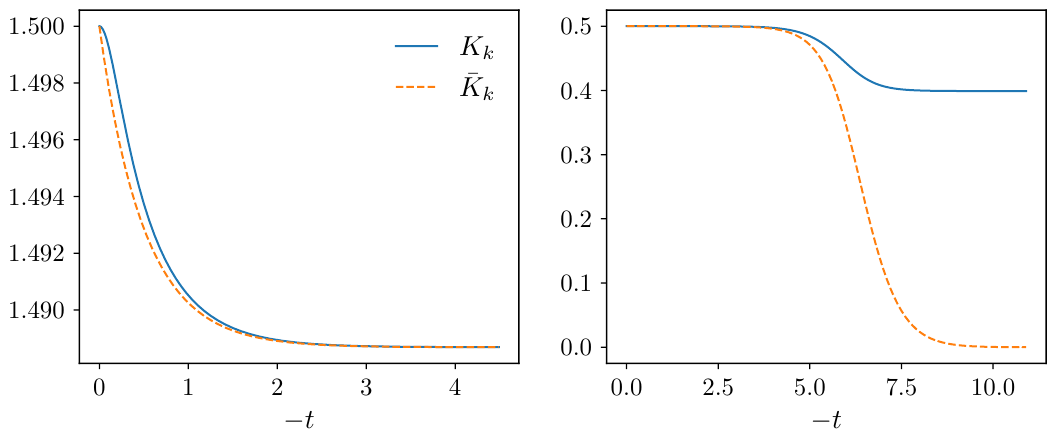
= v /π Z ( 0 ) and ¯ K = v /π Z Figure 2: K vs k in the Luttinger-liquid phase with k k 1 x , k 1, k Λ = 1, u / Λ 2 = 0.01 and K = 1.5 (left) and the Mott-insulating phase with Λ = 1, u / Λ 2 = 0.001 and K = 0.5